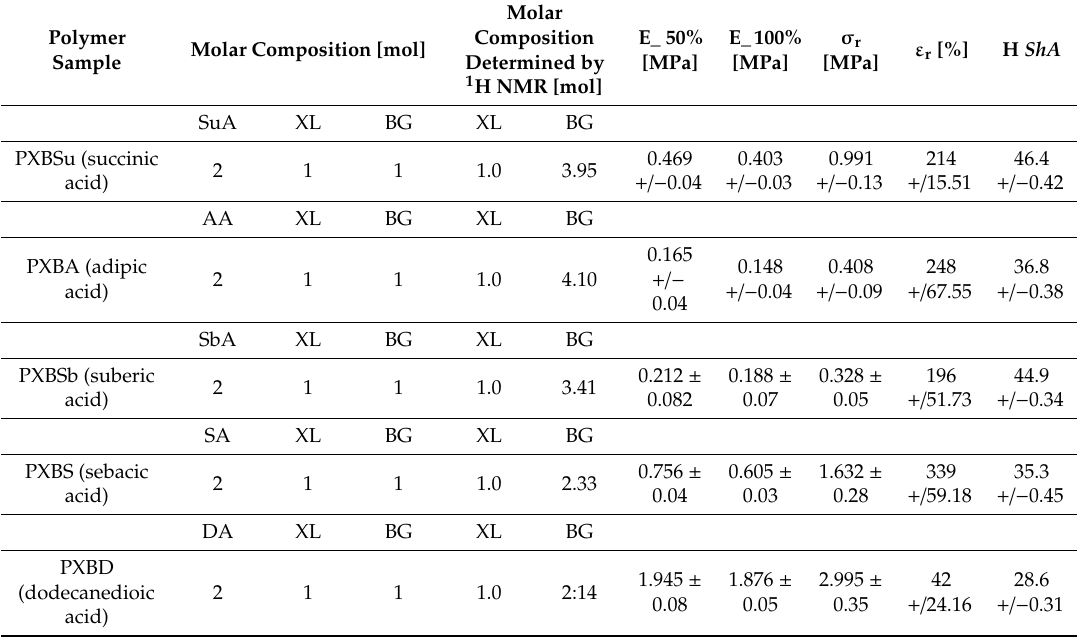
Table 1. Composition and selected properties of poly(xylitol succinate- co -butylene succinate) (PXBSu), poly(xylitol adipicate- co -butylene adipicate) (PXBA), poly(xylitol suberate- co -butylene suberate) (PXBSb), poly(xylitol sebacate- co -butylene sebacate) (PXBS), poly(xylitol dodecanedioate - co -butylene dodecanedioate)